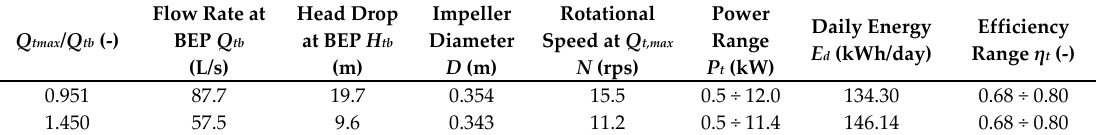
Table 1. PAT design parameters as a function of Q t,max / Q tb ratio—Scenario 1. Q tmax / Q tb